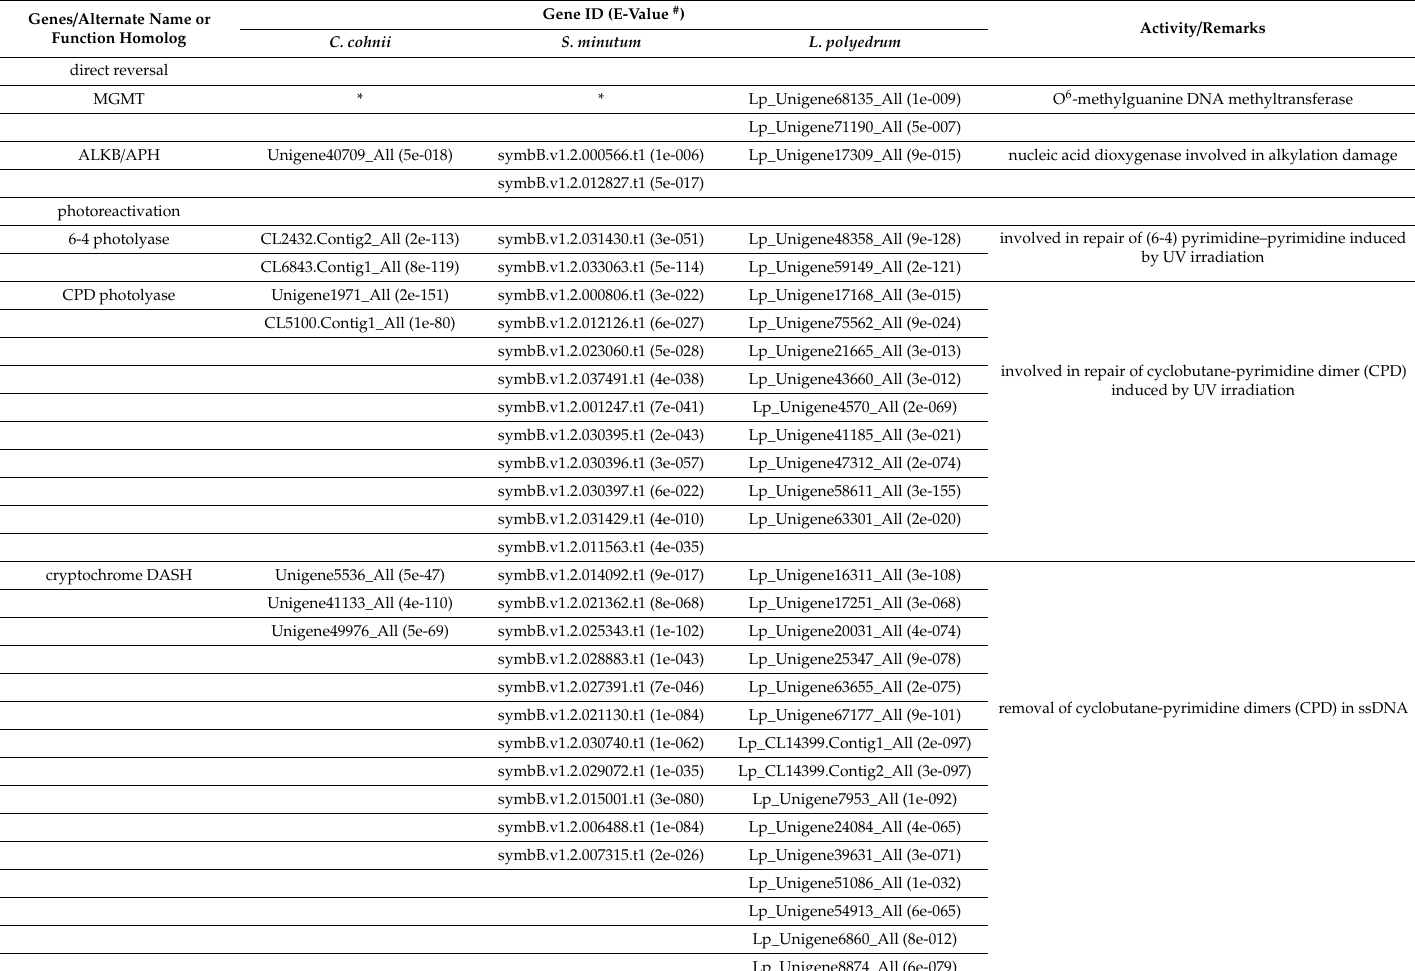
Table 2. Predicted dinoflagellate orthologues in direct reversal of DNA damage and